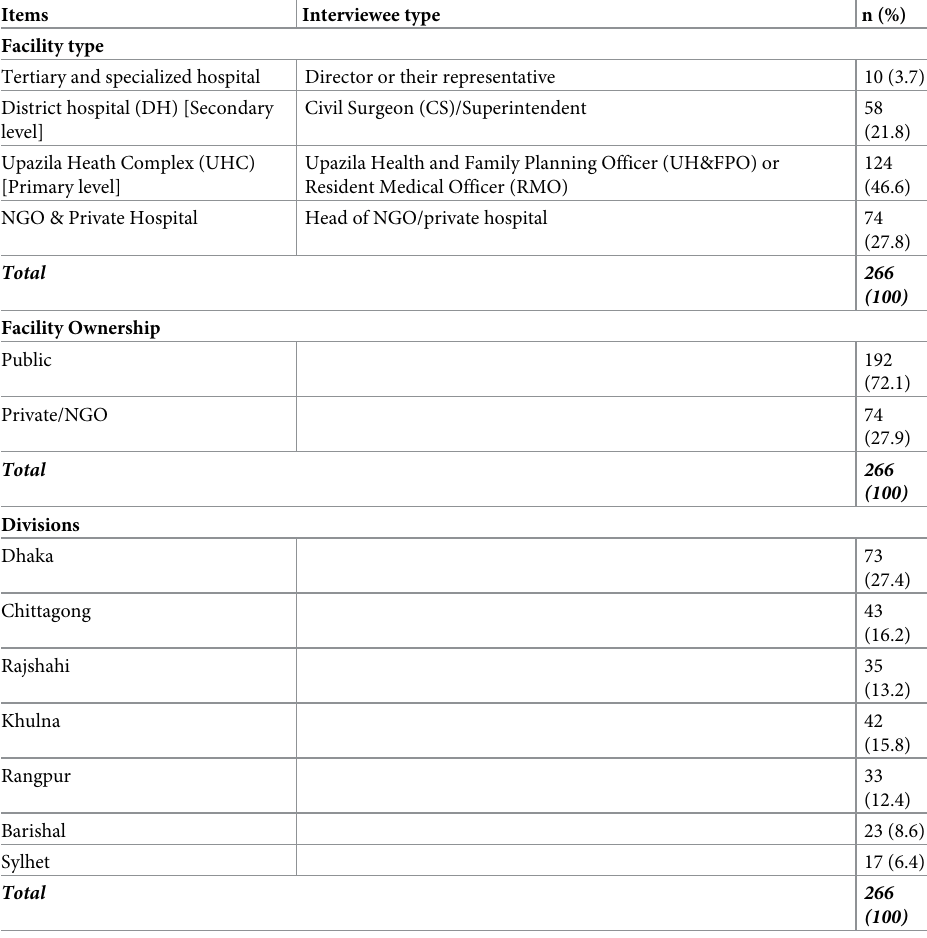
Table 2. Mean characteristics of health facilities providing diabetes mellitus